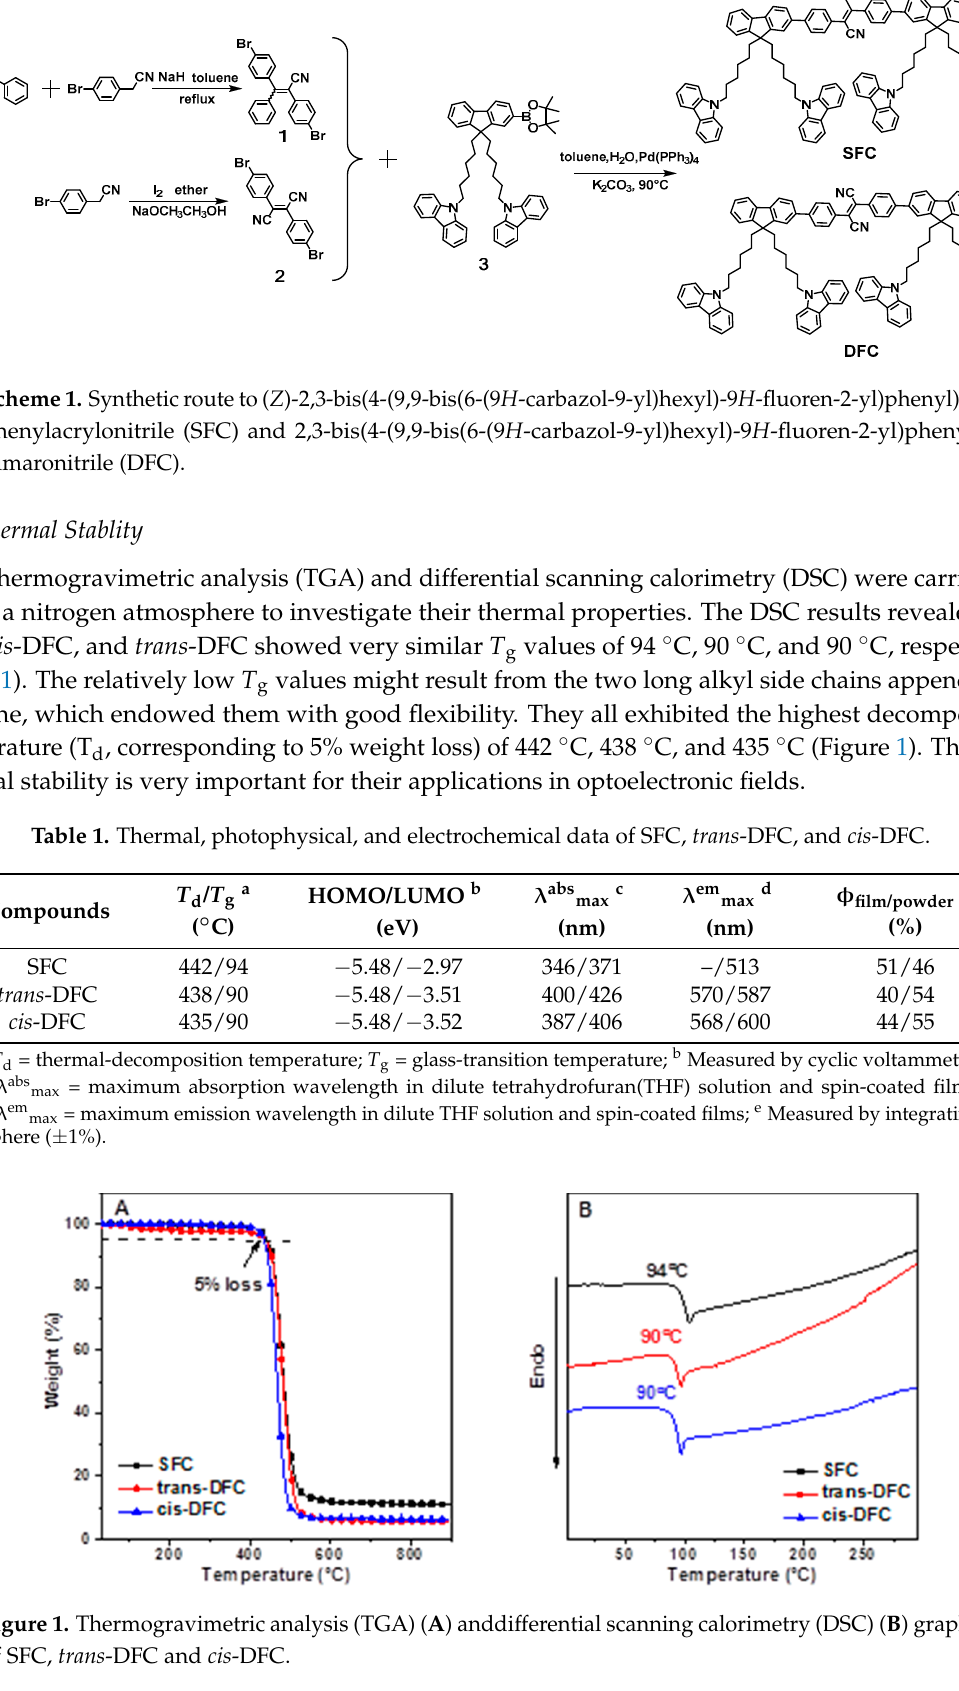
Figure 1. Thermogravimetric analysis ( TGA) ( A ) anddifferential scanning calorimetry (DSC) ( B ) graphs of SFC, trans -DFC and cis -DFC.